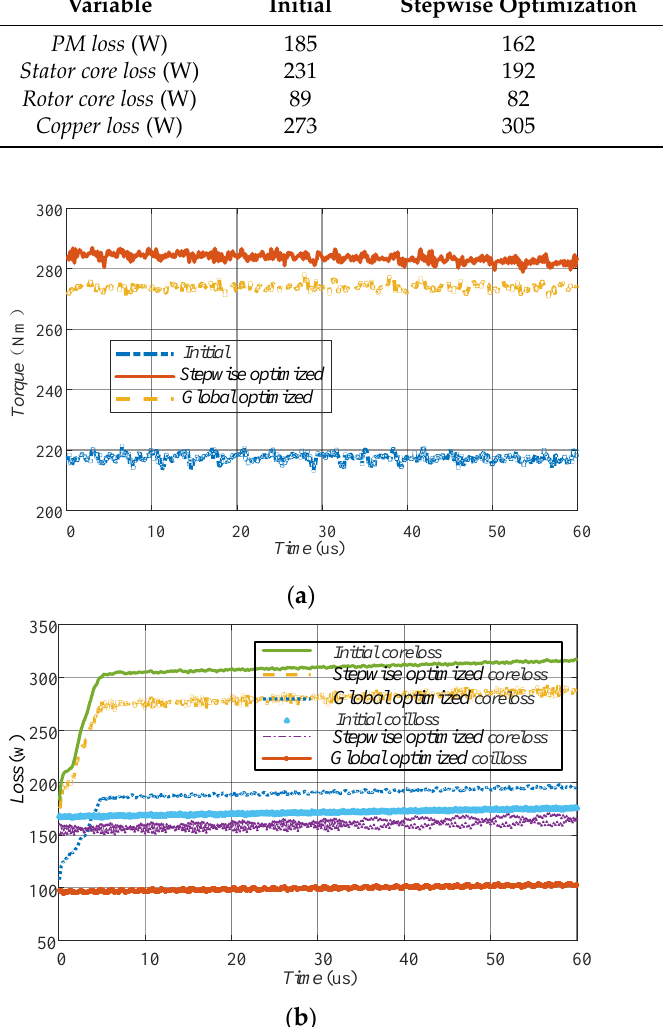
Figure 9. Comparison of torque and loss before and after optimization. ( a ) Simulated Torque wave of three design points. ( b ) Simulated coil loss and core loss wave of three design points.